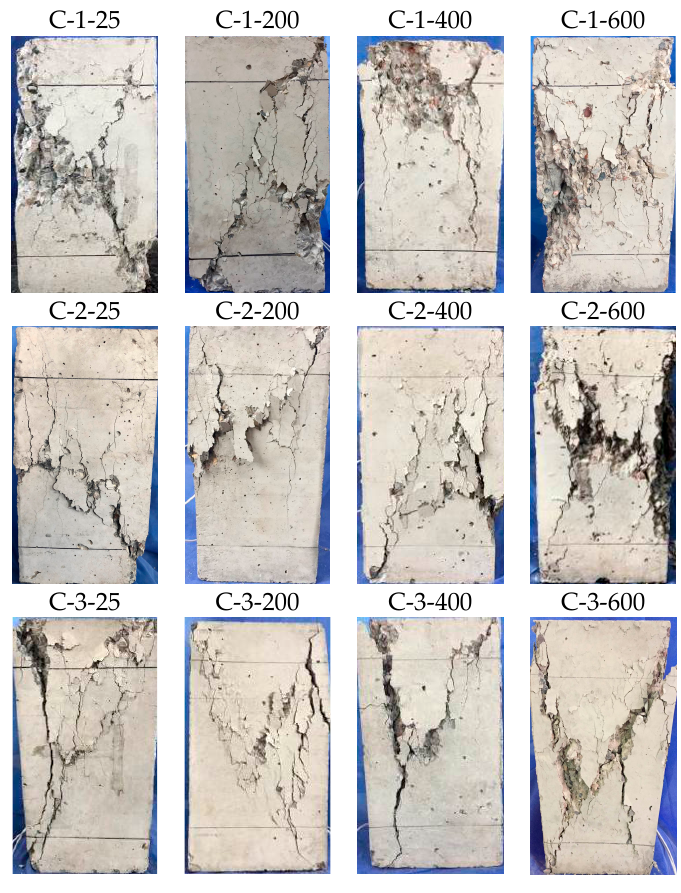
Figure 7. Failure modes of the compression test.